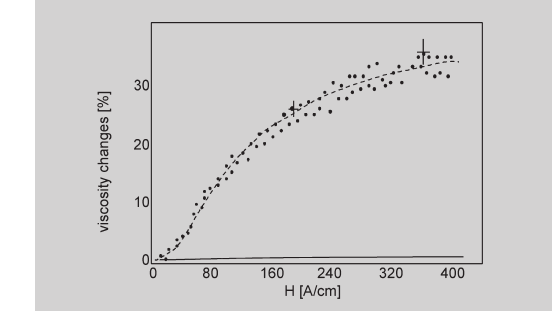
Figure 3 (left): Relative change of viscosity in a commercial ferrofluid normalized with <sin 2 β > for three different field direc- tions (Axial: full line; Radial: dotted line; Azimuthal: dashed line). All curves are given with representative error bars. Figure 4: Relative change of viscosity obtained in a commercial magnetite based ferrofluid and comparison with Eq. 1 (Full line: theory calculated using the fluids parameters; Dashed line: fit of Eq. 1 to the experimental